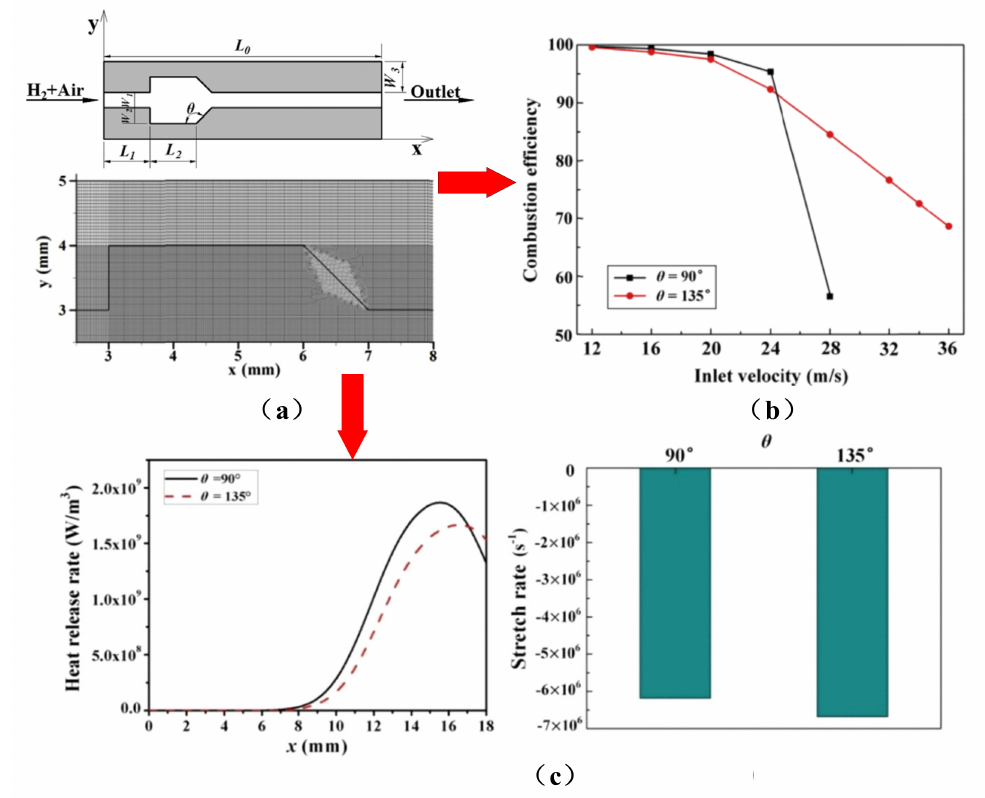
Figure 14. Combustion efficiency, heat release rate, and stretch rates of the combustor, ( a ) Combustor grids, ( b ) Combustion efficiency, ( c ) Heat release rate and Stretch